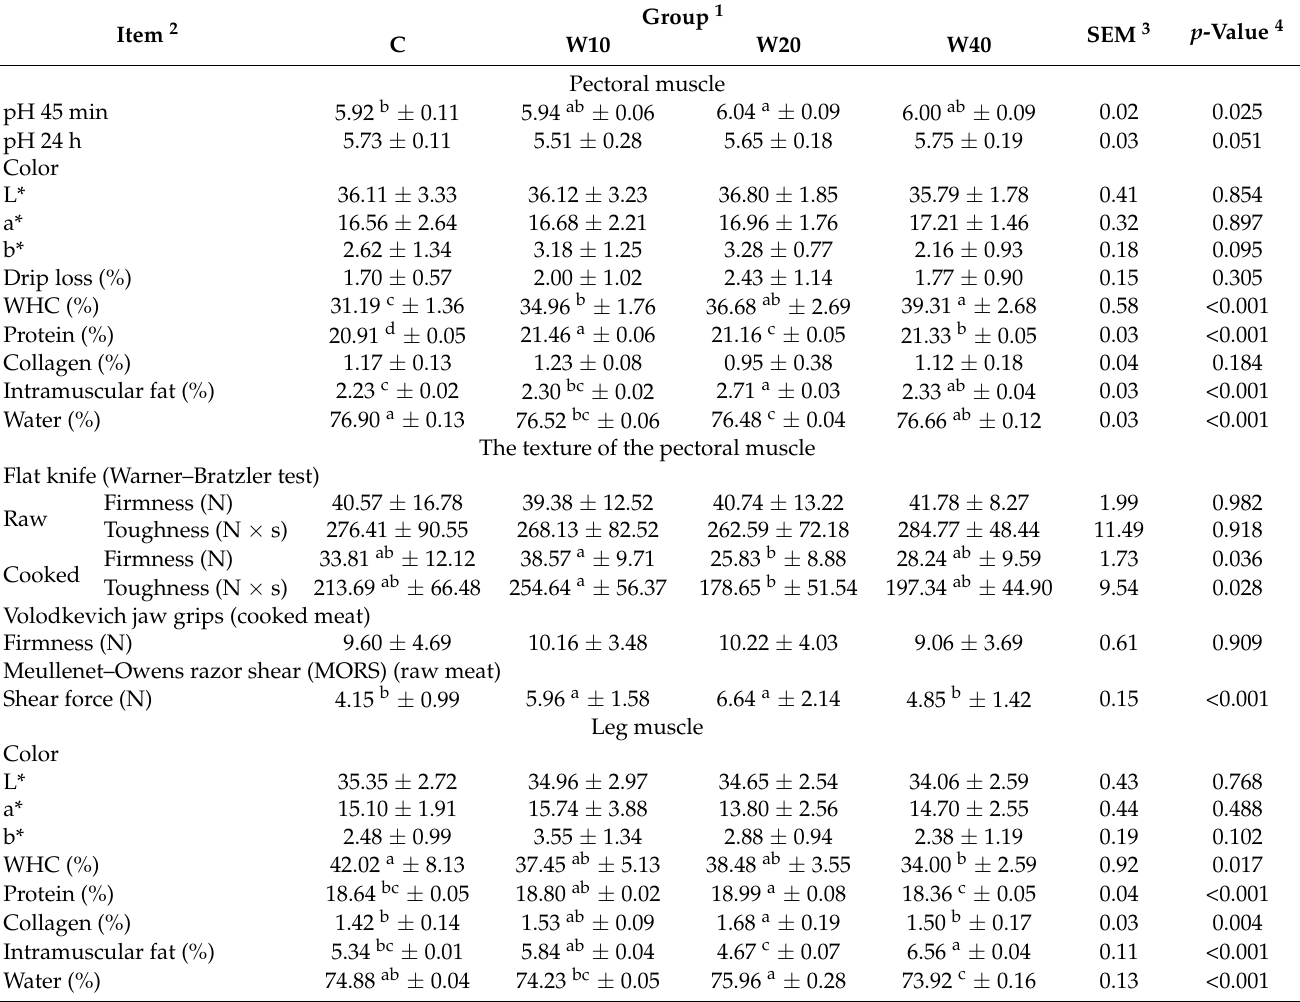
Table 5. Physicochemical features of broiler duck pectoral muscle after 7 weeks of